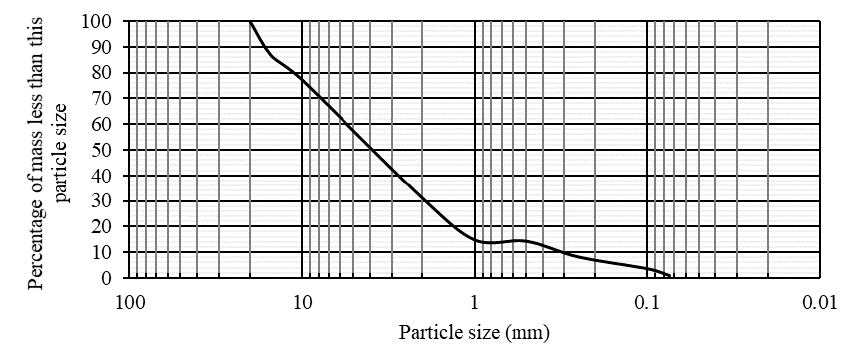
Figure 2. Grading curve of soil-rock mixture.